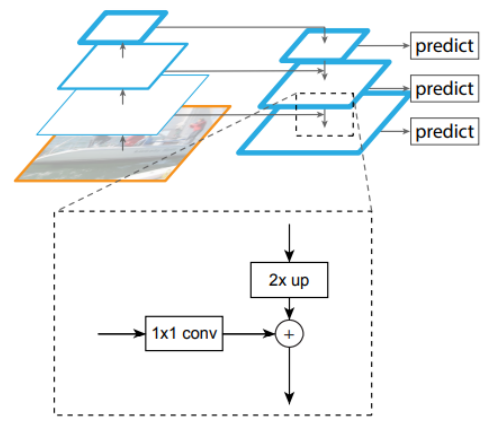
Figure 4. FPN top-down perspective